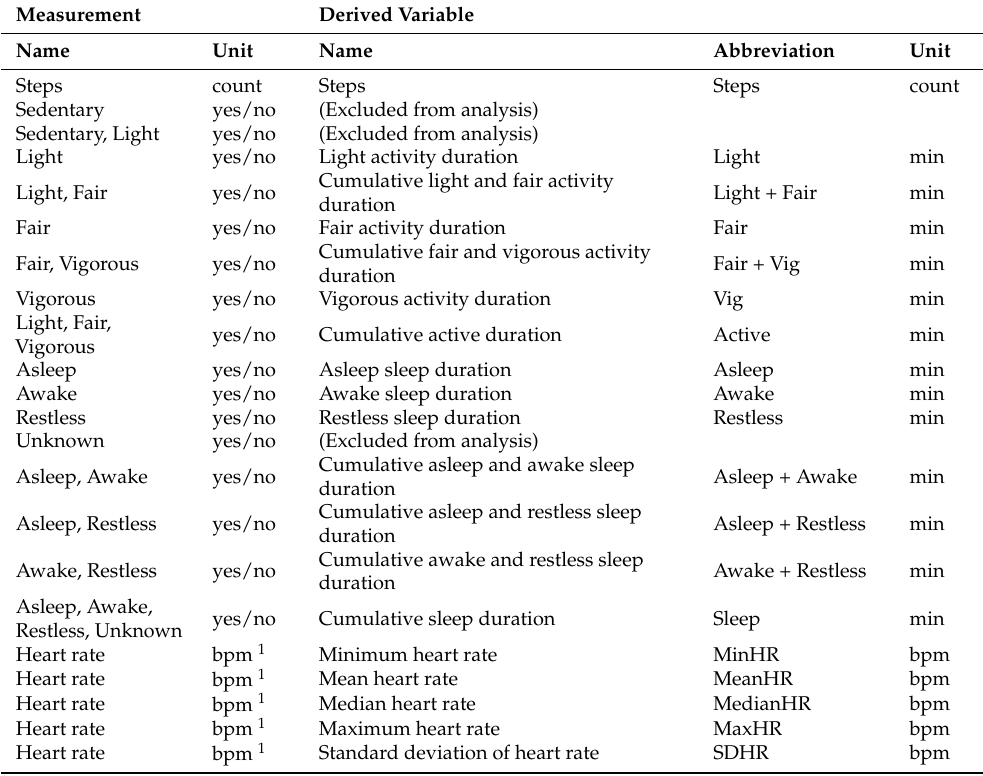
Table 2. Fitbit measurements and derived variables with abbreviations and